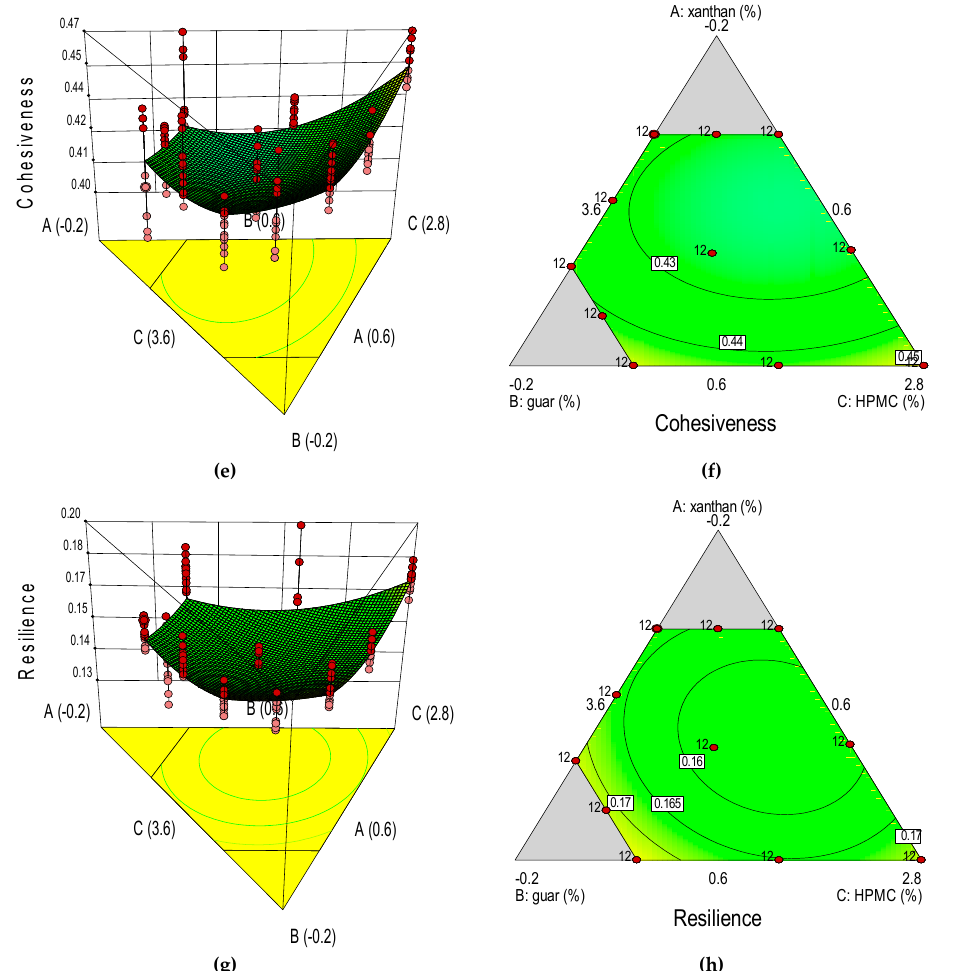
Figure 3. Three-dimensional surface (3-D, left) and two-dimensional contour (2-D, right) plots showing the effect of xanthan ( A ), guar ( B ), and HPMC ( C ) gums on bread textural profile analysis (TPA) of hardness (g), adhesiveness (g·s), cohesiveness (dimensionless) and resilience (dimensionless), were: ( a ), hardness 3-D; ( b ), hardness 2-D; ( c ), adhesiveness 3-D; ( d ), adhesiveness 2-D; ( e ), cohesiveness 3-D; ( f ), cohesiveness 2-D; ( g ), resilience 3-D; and ( h ), resilience 2-D.